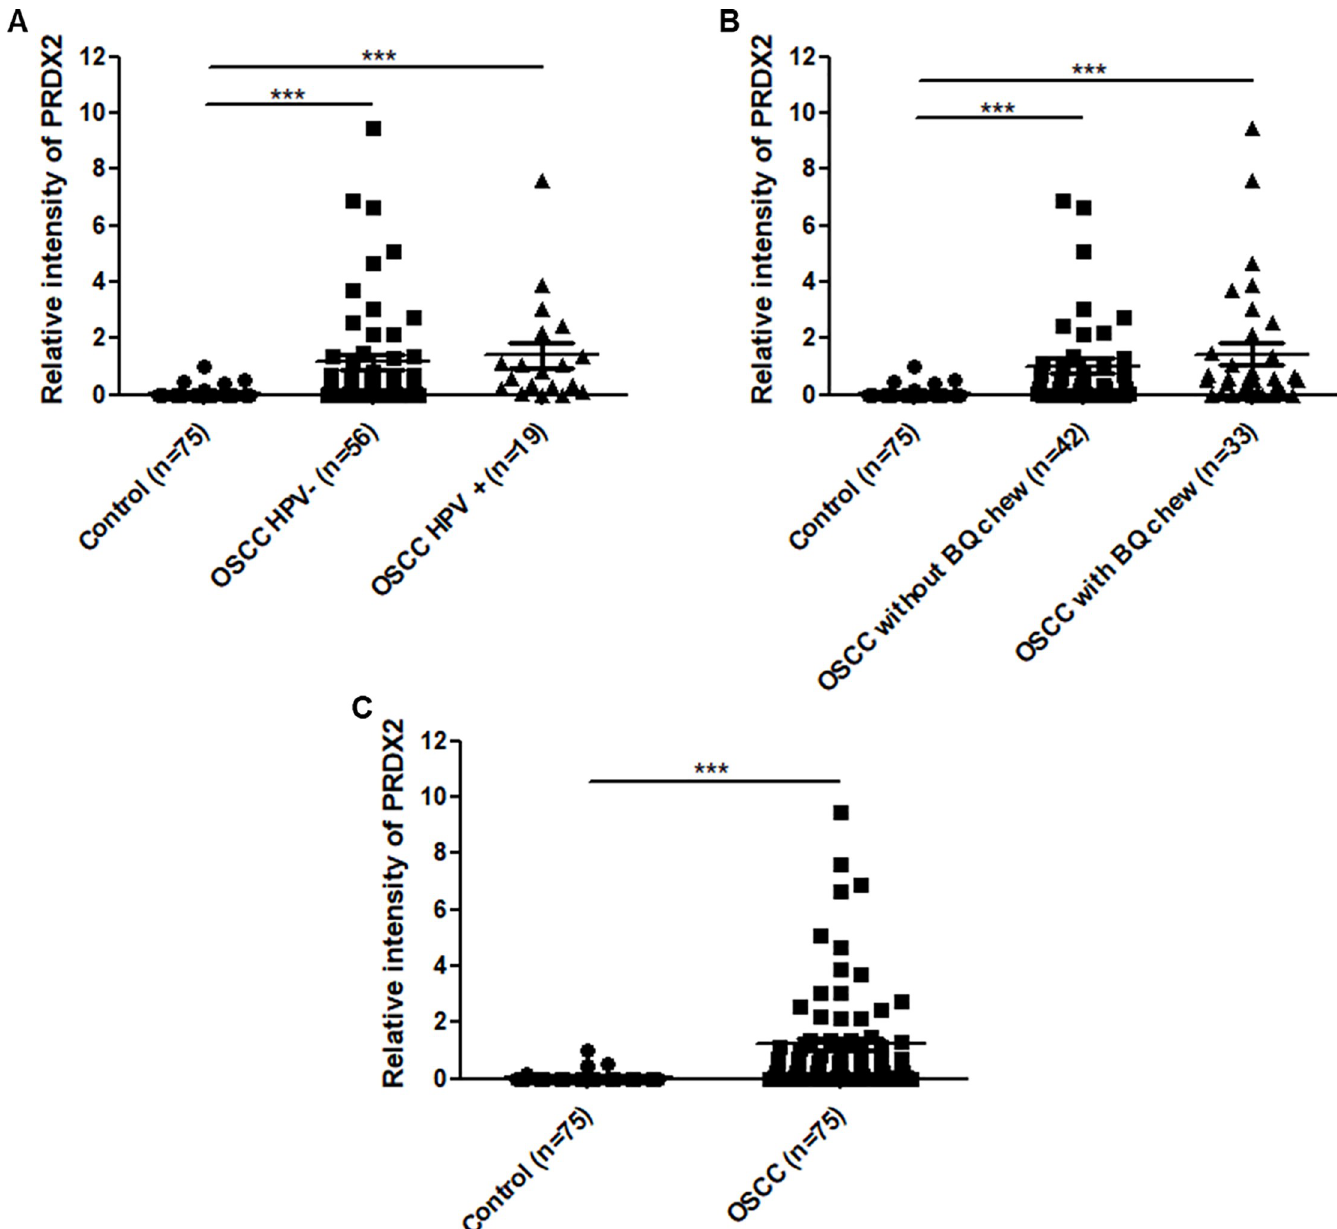
Fig 1. Relative intensity of PRDX2 in OSCC with/without HPV infection, or history of betel quid chewing. PRDX2 protein was detected by western blot in either exfoliated normal oral cells (cancer-free control; n = 75) or lesion cell samples with HPV-positive (n = 19) and negative (n = 56) OSCCs (A), and history of betel quid chewing (n = 33) and non-chewing (n = 42) (B). In addition, this protein was evaluated to compare between cancer-free control (n = 75) and OSCC (n = 75) groups (C). Beta-actin was used as an internal control. One dot in the scatter plot represents relative intensity of PRDX2 of a single sample. Error bars in the scatter plots represent the mean with standard error of the mean (SEM). Mann-Whitney test was used to compare expression levels. ��� denotes statistically significant differences as P <